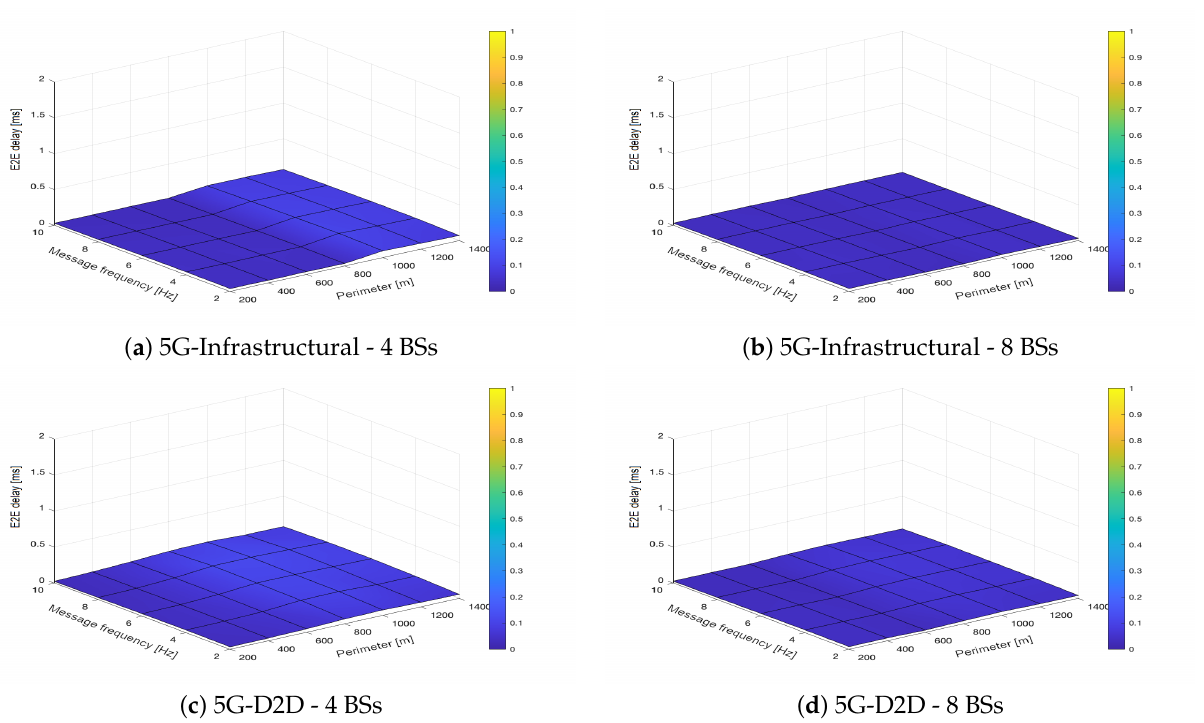
Figure 20. E2E latency simulated for the both modes of the 5G-based C-V2X technology, both infrastructure density deployments and traffic intensity of 250 vehicles per